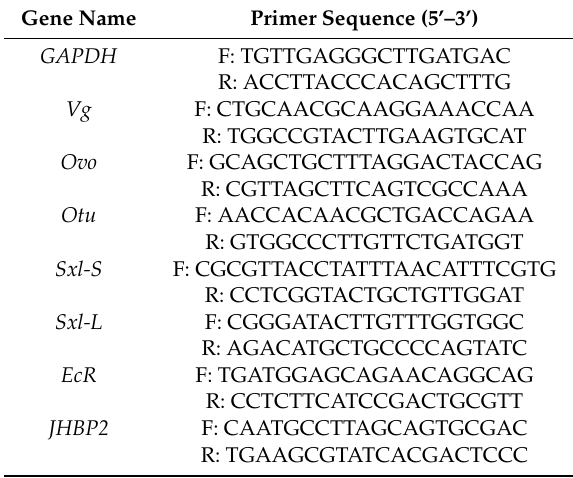
Table 1. Primer sequence for